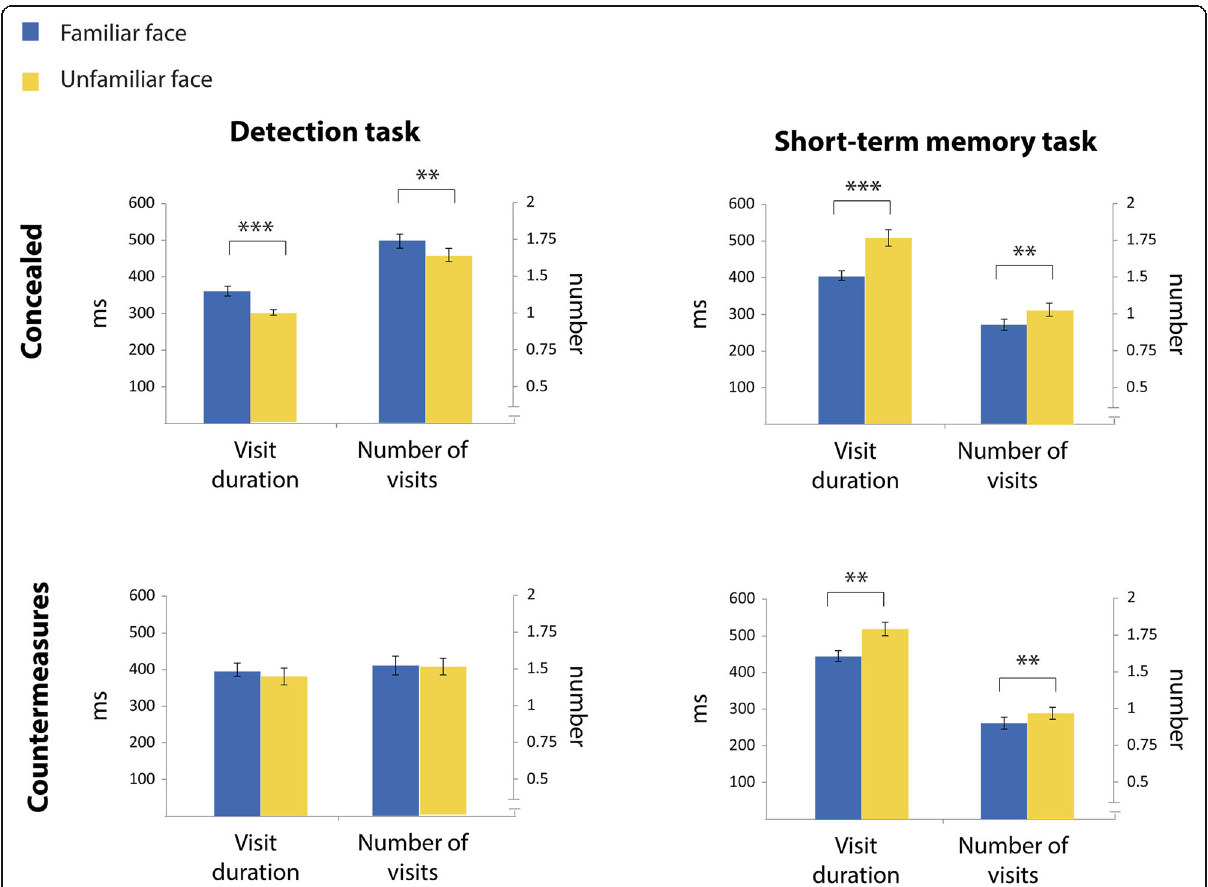
Fig. 3 Number of visits and durations in the current study (left panel) and in the previous one (right panel). Each graph depicts the mean duration of visits (consecutive fixations on a specific face before moving to a different face) and their number, separately for familiar (blue) and unfamiliar (yellow) faces. Error bars indicate ± 1 standard error (SE). (** p value < 0.01, **** p value < 0.001 for paired t test comparisons between visits to familiar and unfamiliar